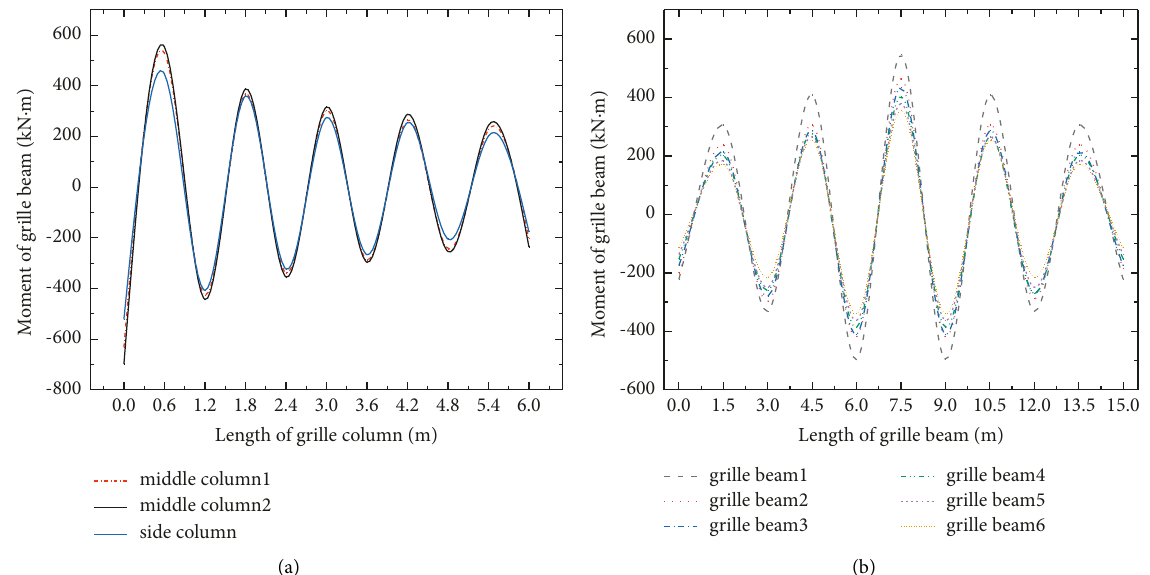
Figure 10: Not considering overall coordination. (a) Bending moment diagram of grille column. (b) Bending moment diagram of grille